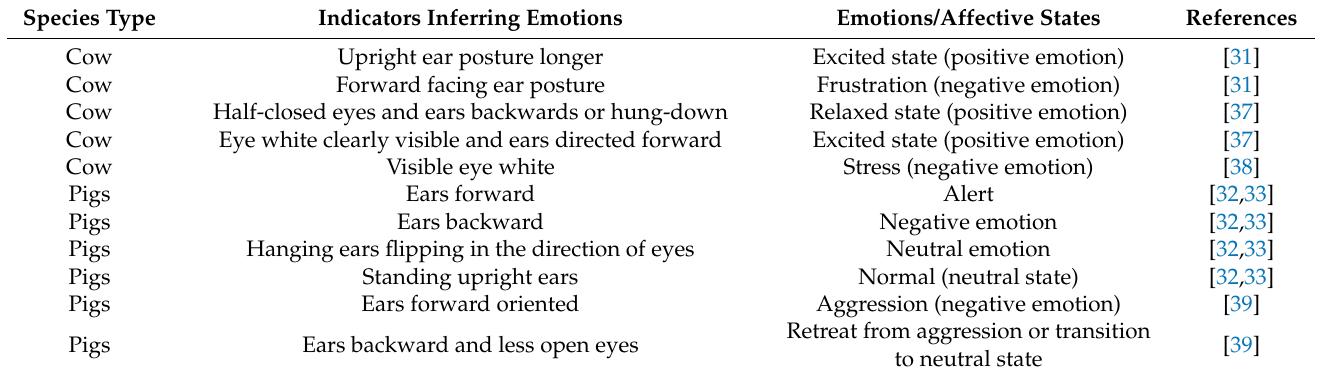
Table 1. Sensing parameters that were used for each of the nine classes related to recognizing emotions of cows and pigs [2]. Species Type Indicators Inferring Emotions Emotions/Affective